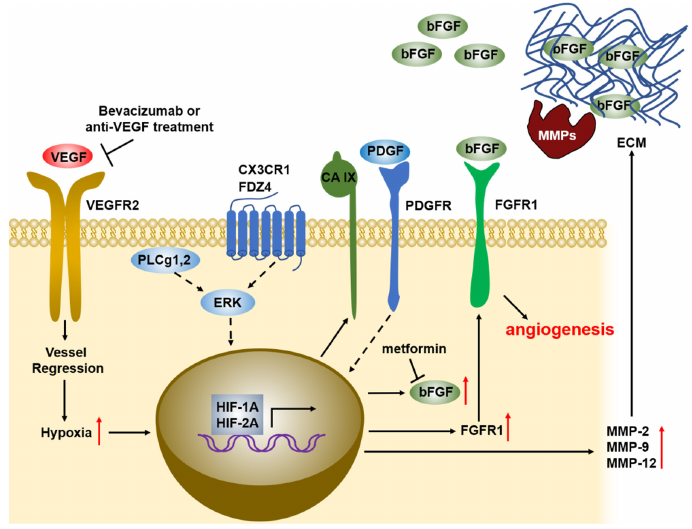
Figure 1. Pathways of bFGF-induced compensation upon anti-VEGF treatment. Bevacizumab or anti-VEGF treatment leads to vascular regression, inducing hypoxia in the surrounding tissues. Hypoxia drives the expression of carbonic anhydrase IX and activates HIF-1A and HIF-2A, in- creasing bFGF levels. Metformin treatment blocks bFGF mRNA and protein levels. A similar in- crease in bFGF levels is achieved upon anti-VEGF treatment in cancer cells, via the upregulation of PLCg1,2, FDZ4 and CX3CL1 (ligand of CX3CR1) with a subsequent ERK activation. PDGFR acti- vation in smooth muscle cells leads to FGFR1 expression. HIF-2A activation induces the expres- sion of MMP-2, -9 and -12, releasing bFGF molecules via extracellular matrix (ECM) degradation. One group of these enzymes are the MMPs, a family of soluble and membrane-an- chored proteolytic enzymes which can degrade components of ECM. It is well-established that MMPs are important regulators of angiogenesis, as they break down matrix compo- nents and thus clear the path for migrating ECs during angiogenesis. Additionally, MMPs can also switch on angiogenesis by liberating matrix-bound bFGF [105,107,108]. MMP-2 expression has been correlated with the de novo formation of small capillaries in tumors. Bevacizumab treatment led to increased expression and enzymatic activity of MMP-2 and MMP-9, common metalloproteinases associated with neovascularization of tumors, in gli- oblastoma cells both in vitro and in vivo [64,109]. Bevacizumab treatment also resulted in the upregulation of bFGF and of the MMP inhibitors TIMP-1 and TIMP-2, as a potential